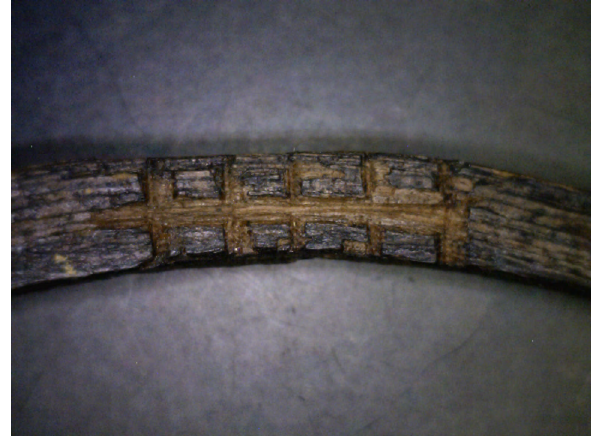
Figure 6. Detail of incised lines on the back of a Button Point Drum (PfFm-01:1749). Photo by Christopher B. Wolff. Canadian Museum of History.